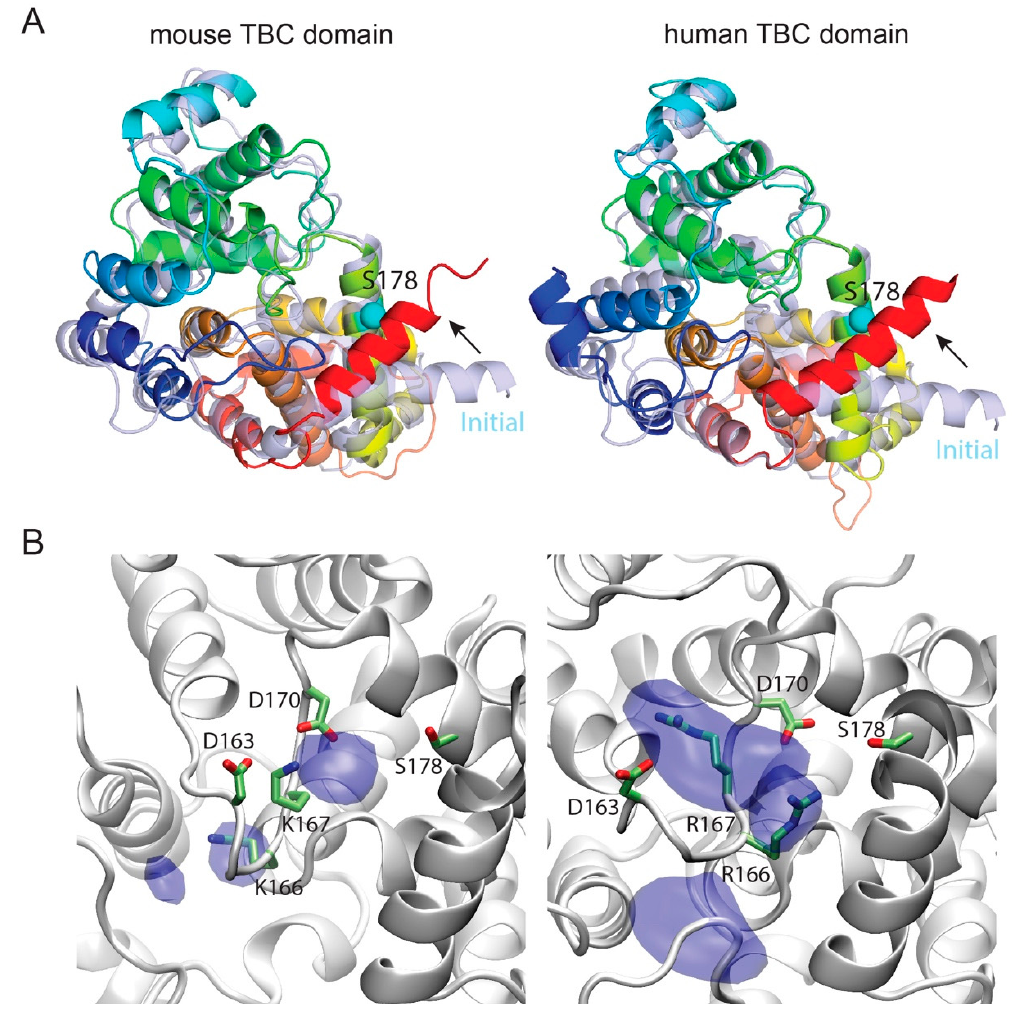
Figure 6. ( A ) Structural superimposition of the initial models of mouse (left) and human (right (light blue colored) with their corresponding final structures after 200-ns molecular dynamics (MD) simulations (rainbow-colored). The reorientation of the C-terminal helix of the TBC domain when comparing the initial model ( α -helix colored in light red) and that after Molecular Dynamics simulation was applied ( α -helix colored in bright red) is indicated as an arrow. The C α of Ser178 in both cases is shown as a cyan sphere. ( B ) Side-chain distribution of residues 166 and 167. The isosurfaces of the distribution of the guanidinium moieties of Arg166 and Arg167 (right panel), calculated from the hTBC simulations and that of the ε -amine moieties of Lys166 and Lys167 (left panel), calculated from the mTBC simulations (nitrogens only), are shown in dark blue. In both cases the isosurfaces refer to the density value of 0.05 atomic mass units per Å 3 . The protein snapshots correspond to the final snapshots from the respective simulations (sim. 2) where the protein is shown as a gray cartoon and the side-chains of residues Asp163, Lys / Arg166, Lys / Arg167 and Asp170 as gray sticks with the headgroups colored by element: N is blue; O is red. D, Aspartic acid; K, Lysine; R, Arginine; S,